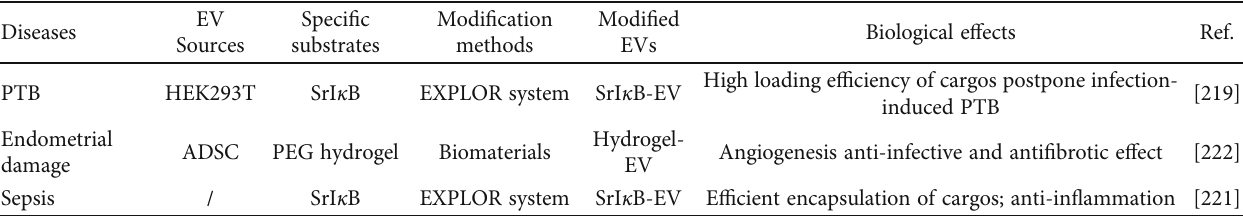
Table 10: Modi fi ed EVs in the therapy of other